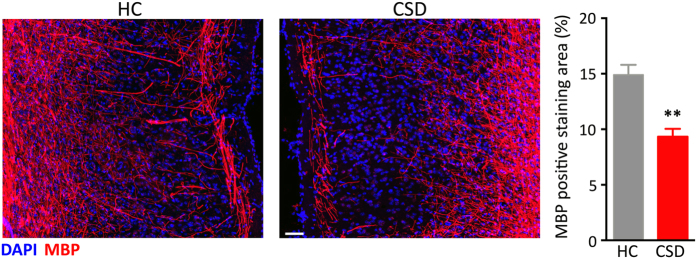
CSD reduced Myelin basic protein (MBP) immunohistochemical staining in the mPFC.Confocal images show differences between HC and CSD MBP immunoreactivity in the mPFC. CSD significantly reduced MBP immunoreactivity in the mPFC. Results are expressed as mean ± SEM (n = 6 per group) Scale bar = 50 μm. Unpaired two-tail t-test: **p < 0.005.